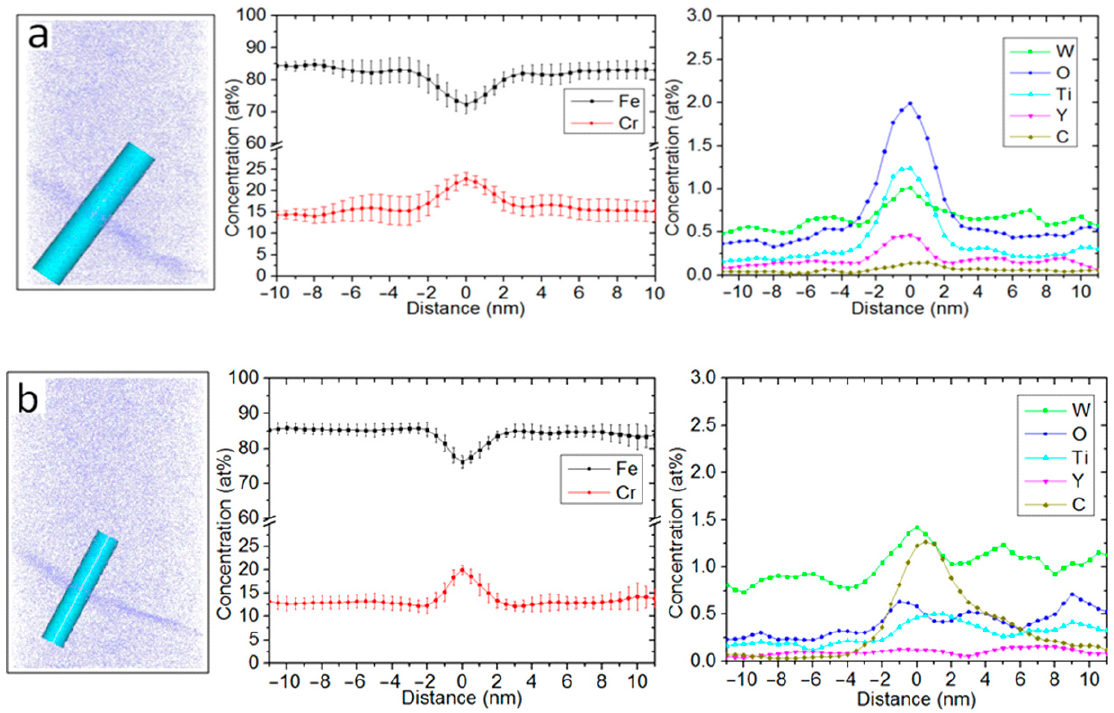
Figure 4. Concentration profiles across a grain boundary in 14YWT alloy ( a ) before heavy ion irradiation and ( b ) after heavy ion irradiation to 100 dpa at 700 °C.